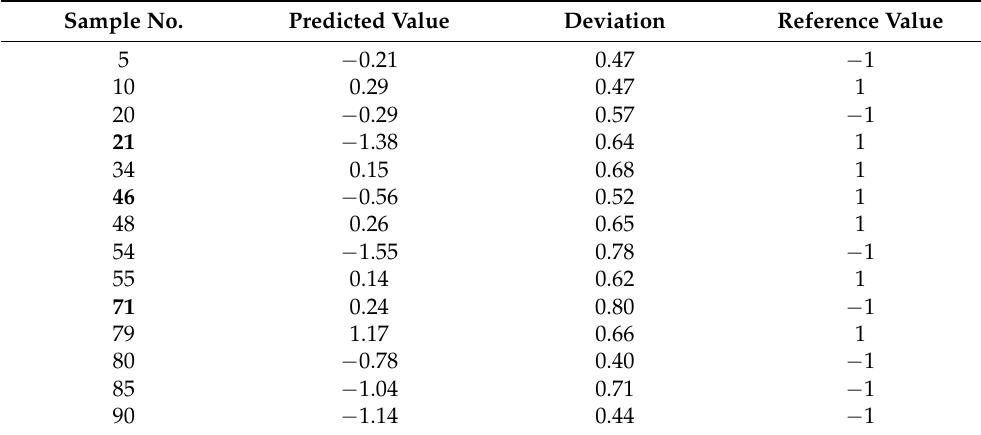
Table 4. Results of prediction of microbiological contamination of urine samples based on the results of analysis of samples with an array of sensors. Sample No.